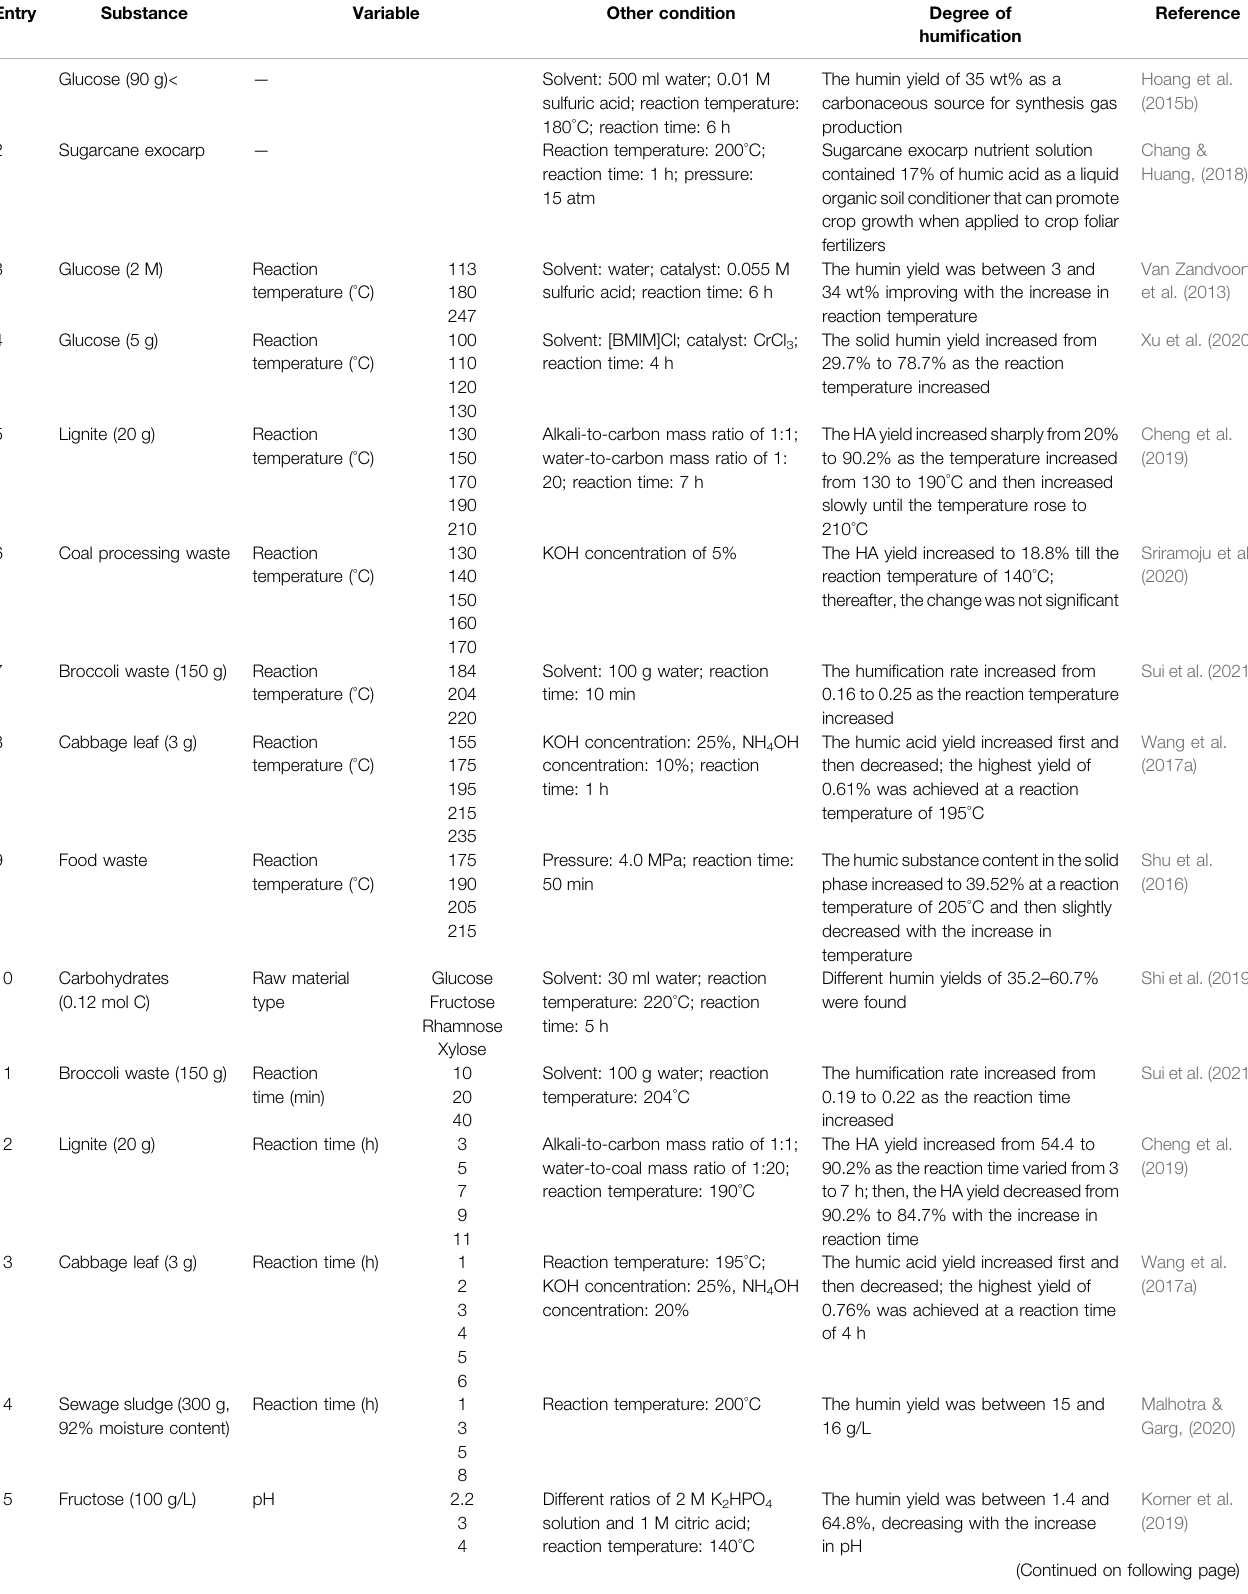
TABLE 4 | Effects of various parameters on the degree of humi fi cation during the hydrothermal